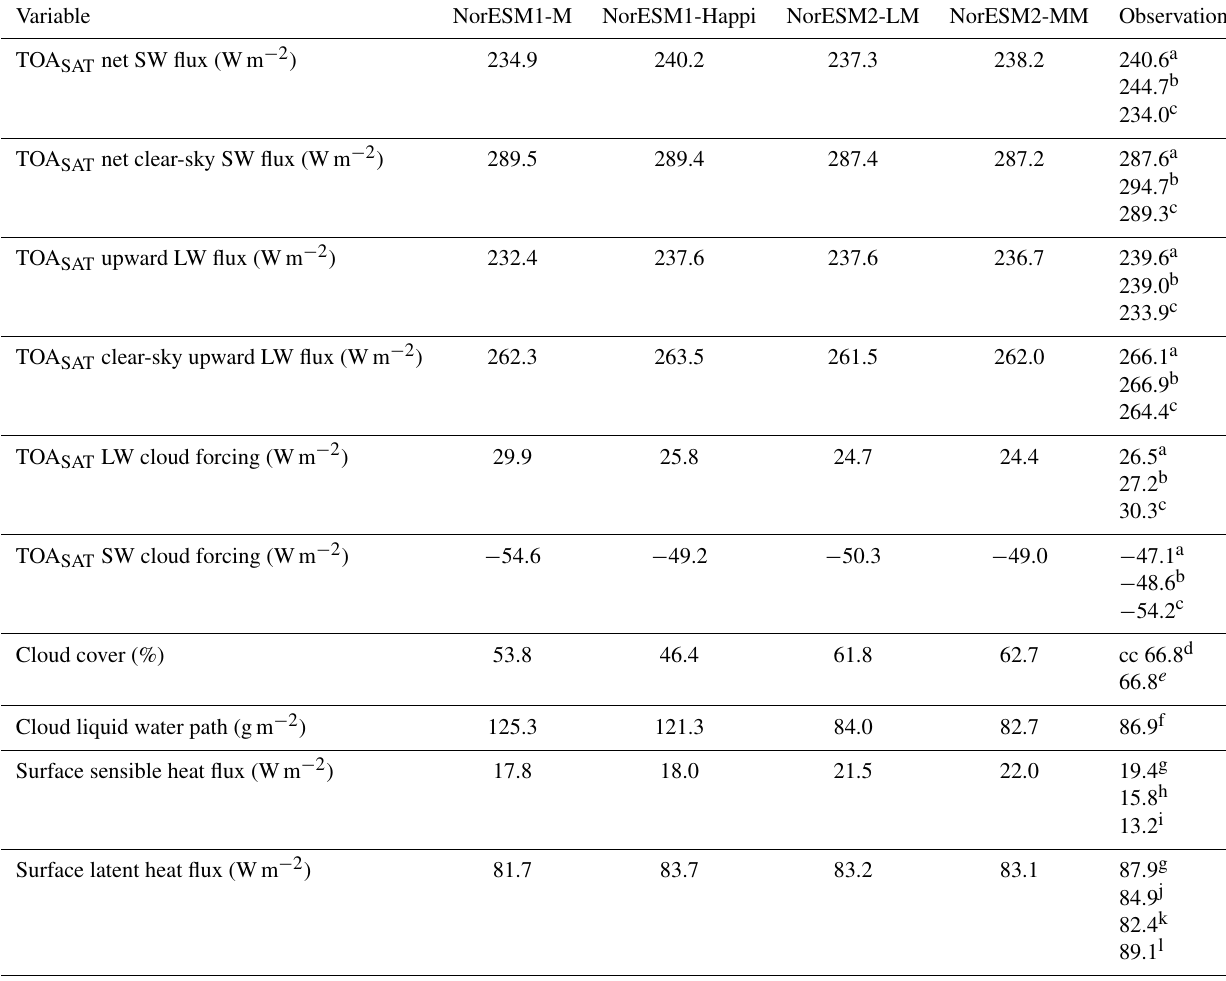
Table 4. Global and annual means from the historical (years 1980–2009) simulations for NorESM2-MM and NorESM2-LM (three-member ensemble average). Values from reanalysis data or observations (references in the last column). The NorESM values are adjusted to com- pensate for the slight deviation between the top of the model atmosphere (abbreviated to TOA) and the top of the atmosphere as seen from satellites (Collins et al., 2006; TOA SAT in this